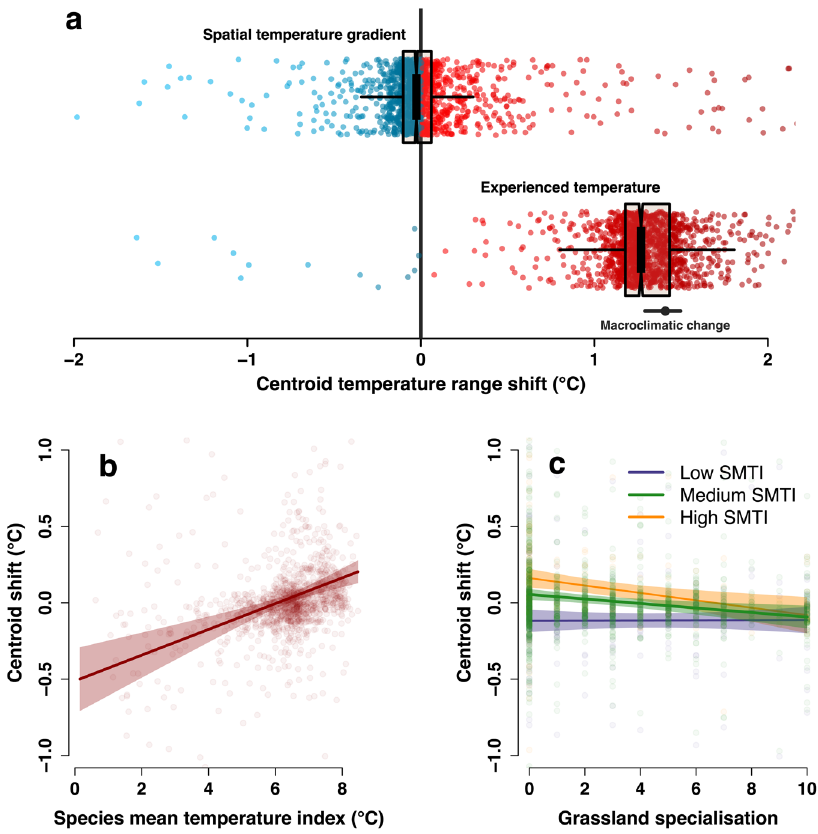
Fig. 3 | Species ’ regional distribution shifts in climate space. Boxplots show shifts in the average climate experienced across a species ’ range, by subtracting mean temperature values of the historical range from those of the modern range ( n =1391species).Shiftsareshownboth a intermsofaspatialtemperaturegradient (based on reference period temperature 1961 – 90) and experienced temperature (1961 – 70 in historical period, 2001 – 2010 in modern period). Boxes show median and interquartile range, with whiskers indicate range excluding outliers. Notches represent 95% intervals around the median. Blue and red points show species with shift values below and above zero, respectively. Black point and whiskers indicate the median and interquartile range of climate change experienced across all grid cells.Lowerpanelsshowtheeffectof b speciesmeantemperatureindex(SMTI)and